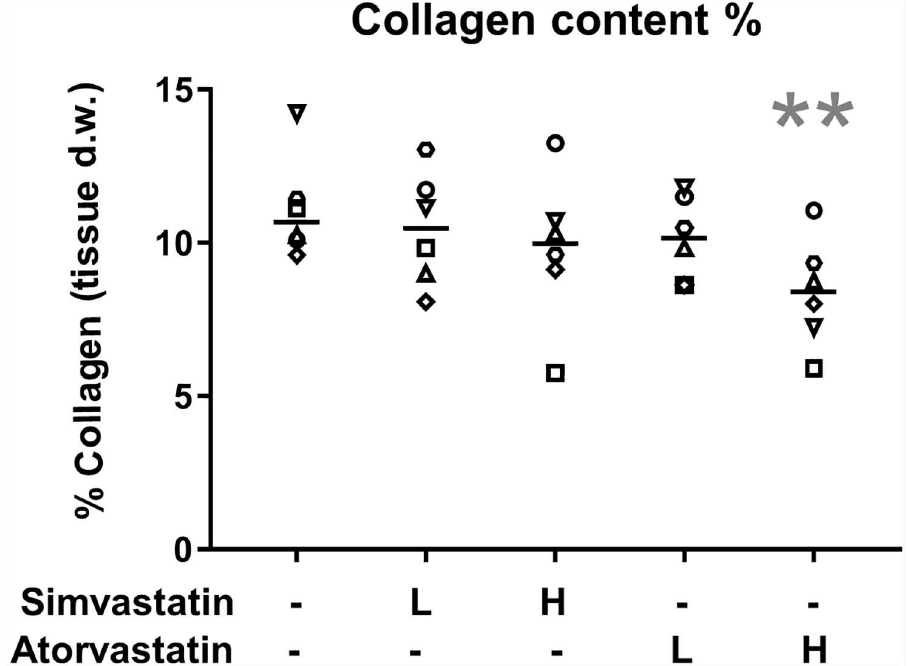
Fig 3. Collagen quantification. Total collagencontent in tendon constructs with or without statin treatment for 7 days. Low dose (L) statin treatment corresponds to 0.05 μ M (simvastatin or atorvastatin) and high dose (H) corresponds to 0.5 μ M. The line represents medianvalue. Individual donor-specific cell lines are represented by the six different symbols. The collagencontent was approximately 10% of the construct dry weight. High dose treatment with atorvastatinreducedthe collagencontent comparedto DMSO-controls, this was not seen after simvastatin treatment. Significant changesfrom DMSO-control are indicatedby ** (p =